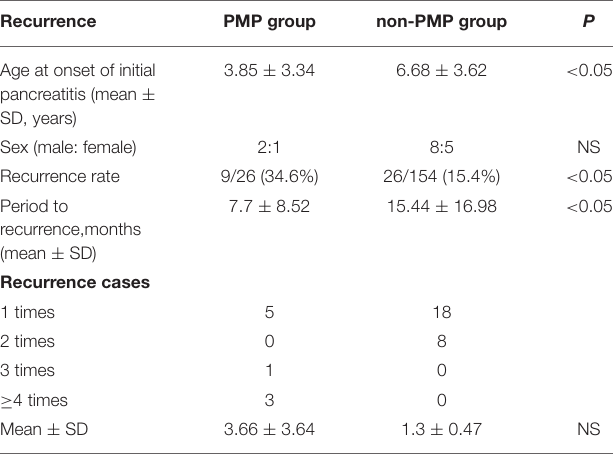
TABLE 4 | Differences in clinical recurrence profiles between the PMP and the non-PMP groups.